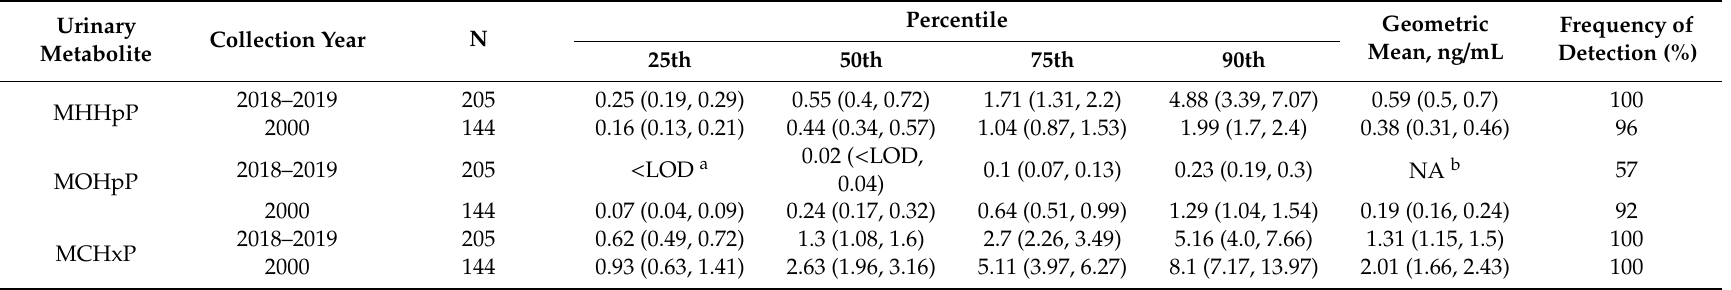
Table 2. Selected percentiles of urinary concentrations (95% CI) of three oxidative metabolites (ng / mL) of diisoheptyl phthalate in a convenience sample of U.S. adults. Urinary